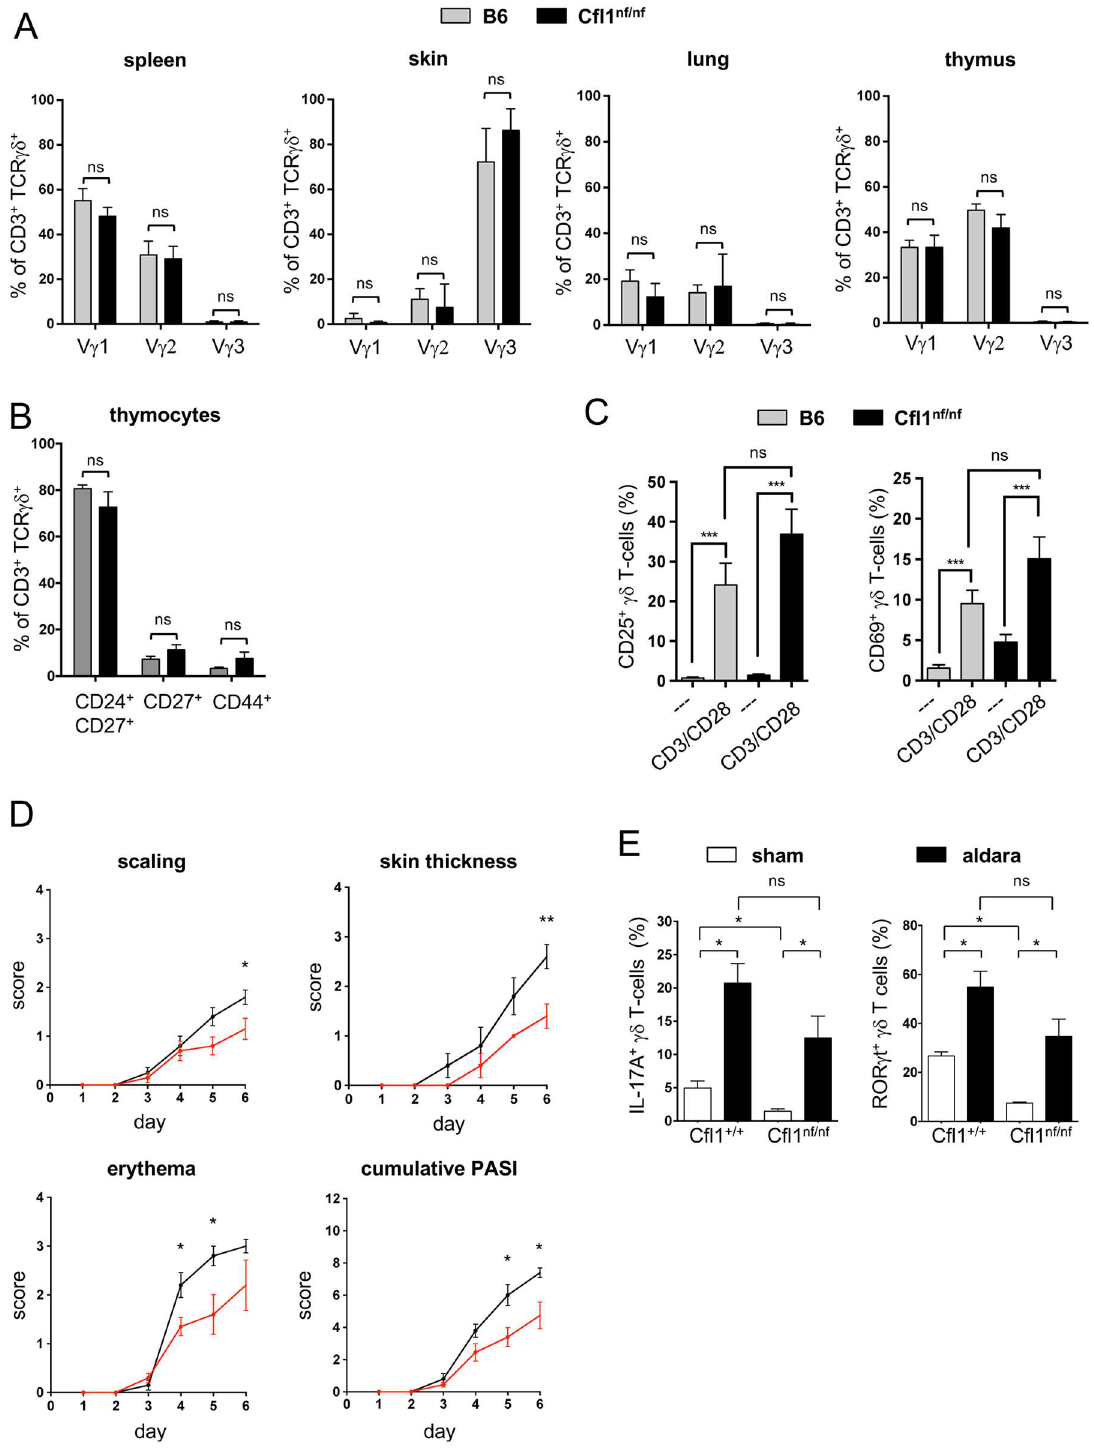
Fig 4. Cfl1 nf/nf mice show normal γδ T-cell subsets which remain functional. (A) Analysis of the surface expression of V γ 1, V γ 2, and V γ 3 of γδ T-cells isolated from the spleen, skin, lung, and thymus of B6 (grey bar) or Cfl1 nf/nf mice (black bar) ( n = 4 independent experiments with (cid:21) 4 mice per group). (B) Analysis of the surface expression of CD24, CD27, and CD44 of γδ thymocytes of B6 (grey bar) or Cfl1 nf/nf mice (black bar) ( n = 4 independent experiments with (cid:21) 4 mice per group). (C) In vitro activation of splenic γδ T cells of Cfl1 nf/nf (black bar) and control mice (grey bar) by plate-bound CD3 and CD28 antibodies for 24 h. Determination of the T-cell